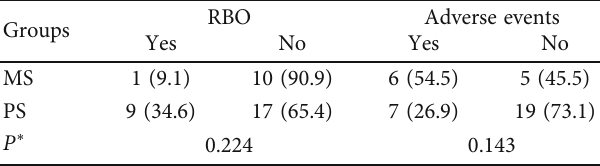
Table 4: E ff ect of MS and PS on RBO and adverse events. RBO Groups